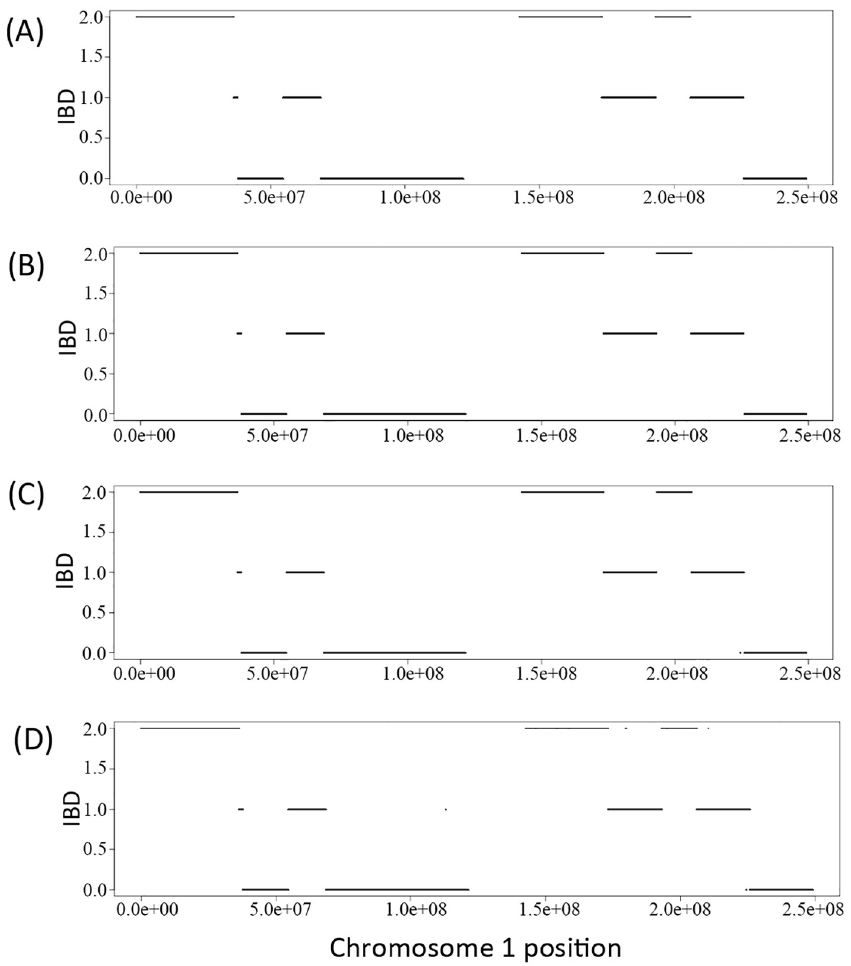
Fig 1. The IBD of the two siblings in a Nuc4 pedigree along the chromosome 1. A) is the simulated true IBD of the siblings, B), C) and D) are the inferred IBD at 30X, 15X and 2X respectively.